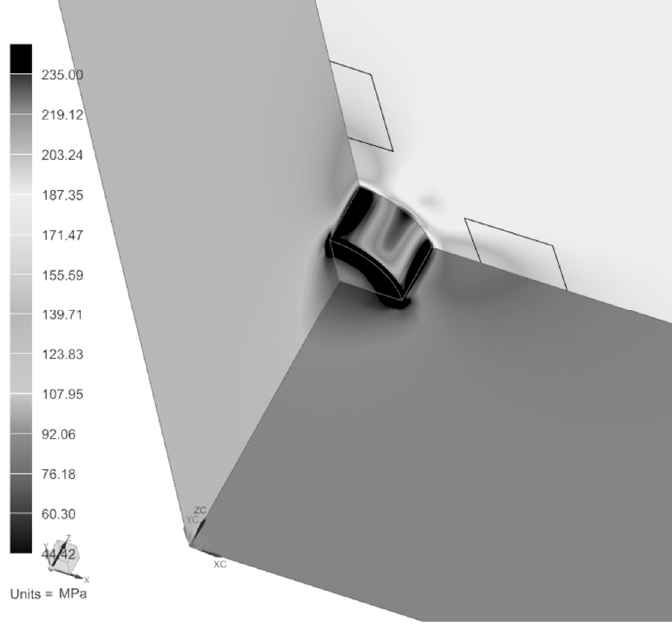
Figure 1. Plastic zone introduced by hole drilling.